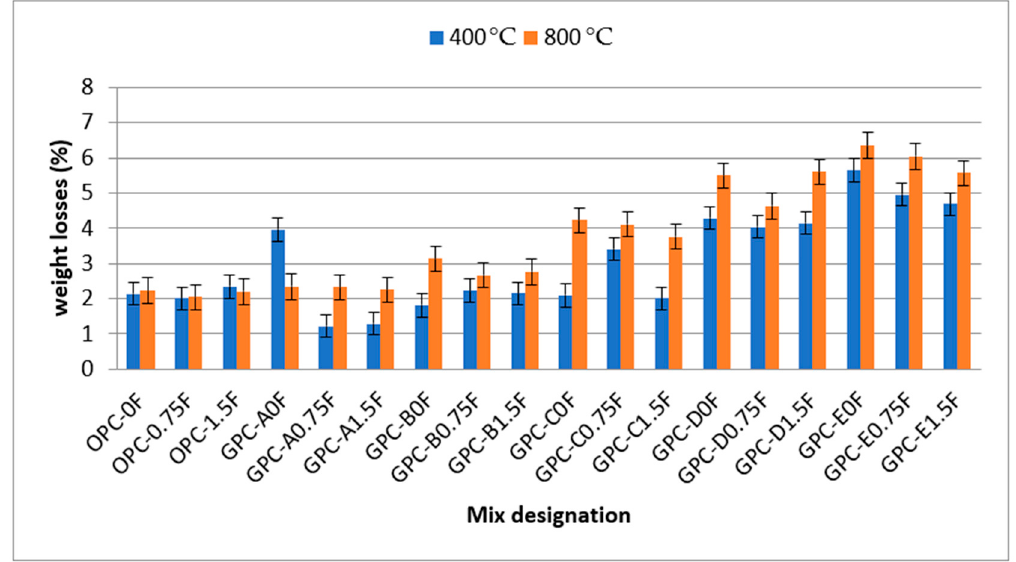
Figure 11. The weight loss values of GPC and OPC mixes after heating the specimens at elevated temperature. The residual compressive strength of OPC and GPC mixes was investigated to be inversely proportional to the temperature and QRD content. The compressive